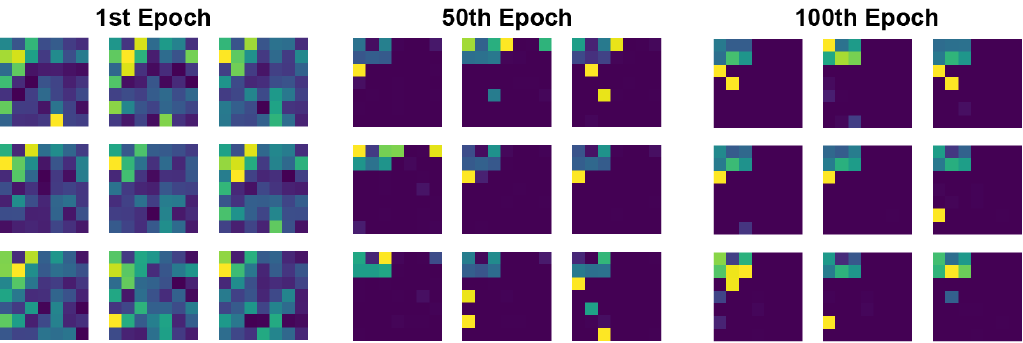
Figure 6. Generated Thyroid images samples through 100 epochs training with a FCN